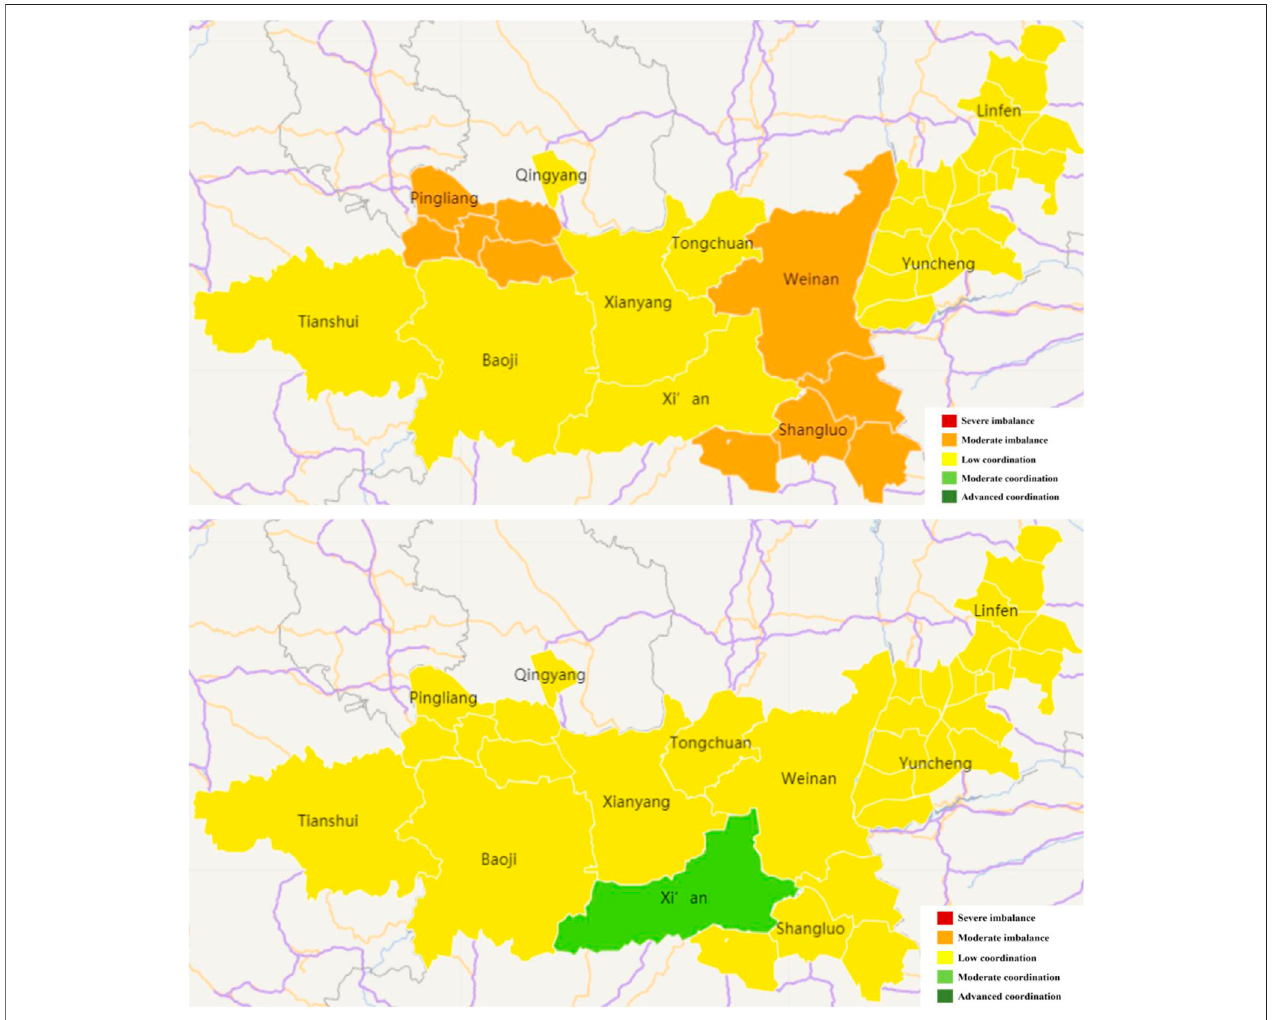
FIGURE 8 | Spatial pattern evolution of coordination degree of urbanization and ecological environment in GZPUA 2008 and 2017.